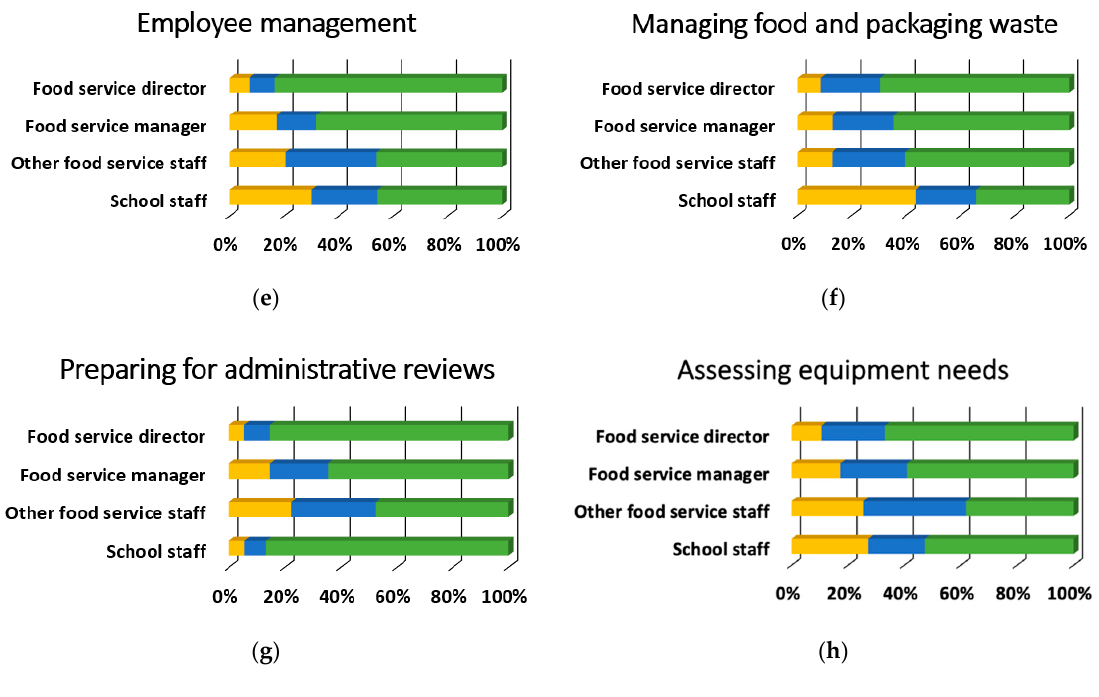
Figure 5. Administration training topic needs that significantly differed by participant role, n = 453 (food service director, n = 151; food service manager, n = 110; other food service staff, n = 63; school staff, n = 129). Described below for each panel are the χ 2 and p -values. ( a ) Certification/verification of benefits (free- and reduced-price meal benefits), χ 2 (6) = 41.0,